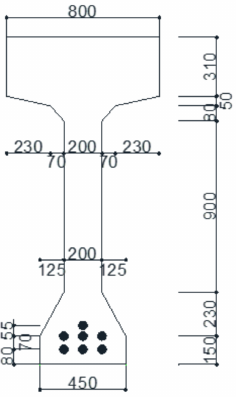
Figure 2. Cross section of the deteriorated bridge (unit: mm).